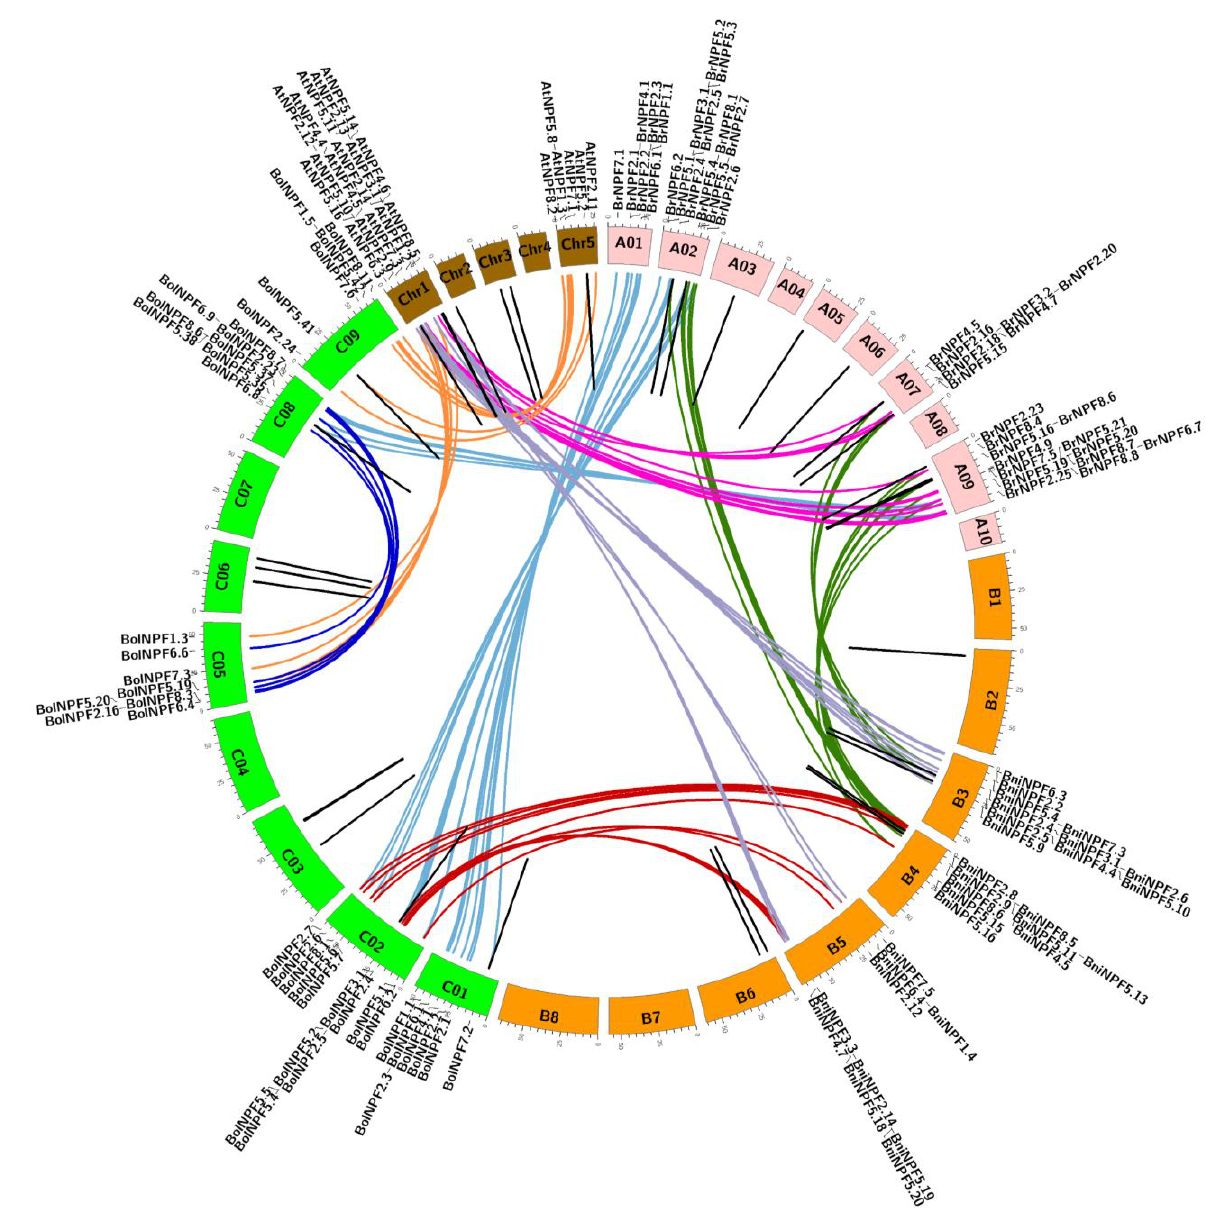
Figure 3. Syntenic relationships among NPF genes of Brassica rapa , B. nigra , B. oleracea , and Arabidopsis . The chromosomes of B. rapa (chromosomes A01 to A10), B. nigra (B1 to B8), B. oleracea (C01 to C09), and Arabidopsis (Chr1 to Chr5) are shown in red, orange, green, and brown, respectively. Collinear gene pairs were mapped onto chromosomes and are connected to each other. The collinear gene pairs from B. rapa and B. oleracea , B. rapa and B. nigra , B. rapa and Arabidopsis , B. nigra and B. oleracea , B. nigra and Arabidopsis , B. oleracea and Arabidopsis are connected by light blue, green, pink, red, purple, and orange lines, respectively. Segmental duplication genes in B. oleracea are connected by dark blue lines. The locations of tandem duplicated genes are indicated with black lines. Only the names of collinear gene pairs are